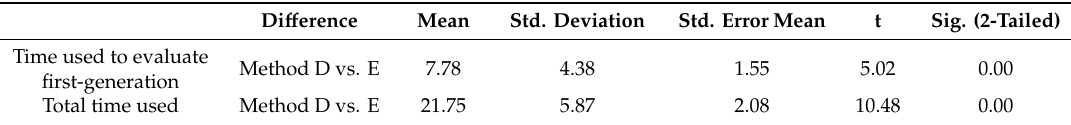
Table 5. Paired-sample T test of the time used to produce the first-generation and total time used with Methods D and E. Di ff erence Mean Std.